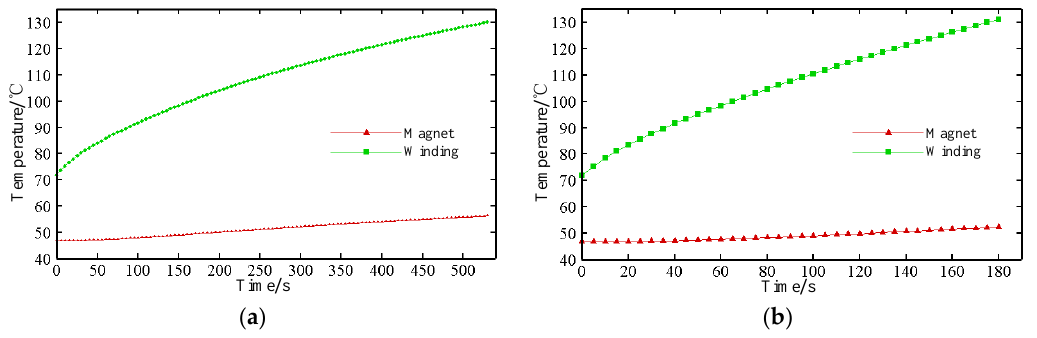
Figure 11. Relationship curves of the operation time and maximum temperature of the windings and magnets: ( a ) relationship curve with thrice the torque; ( b ) relationship curve with four times the torque.